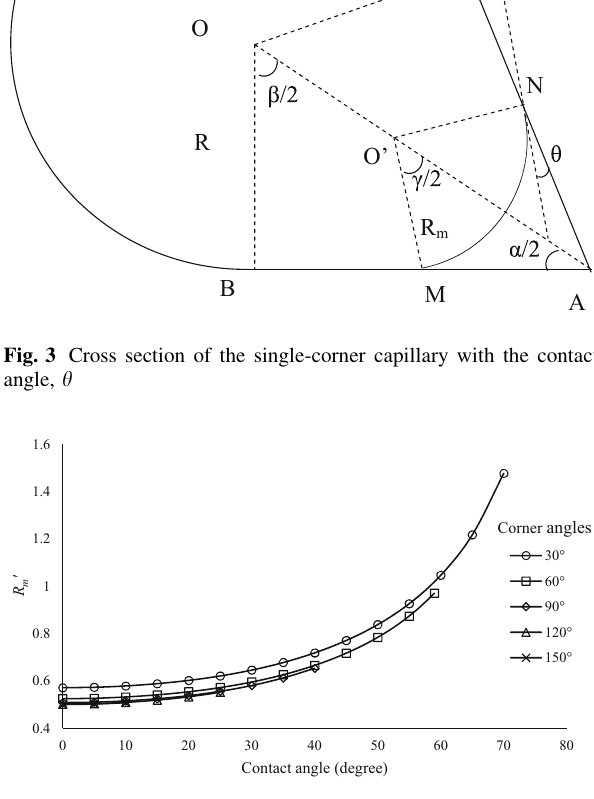
and the radius of the meniscus is half the radius of the